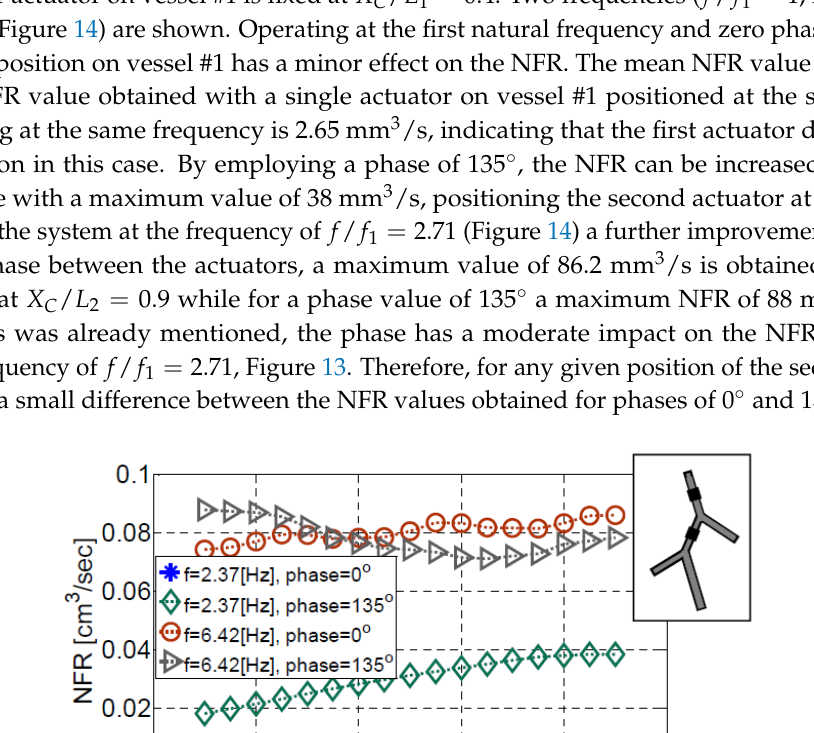
X L = Two / 0.4 1 C